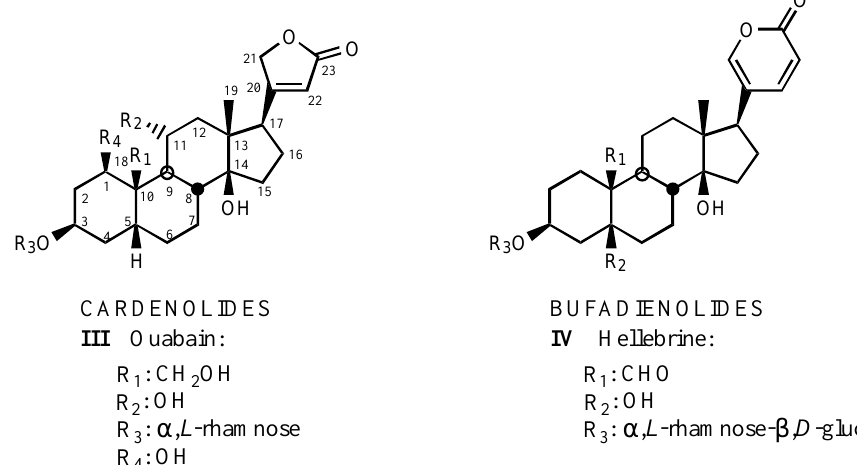
Figure 2. Structure of cardenolides and bufadienolides.